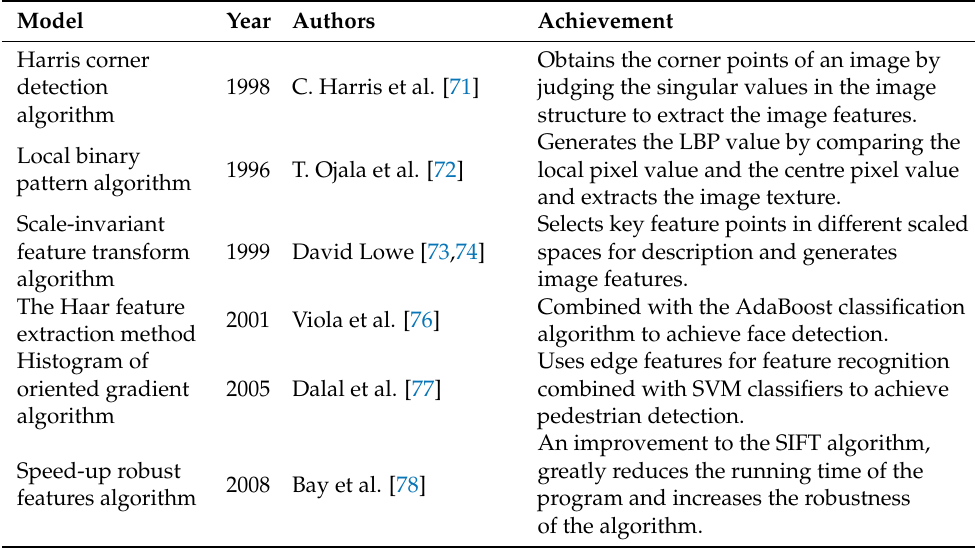
Table 3. Comparison of image feature extraction